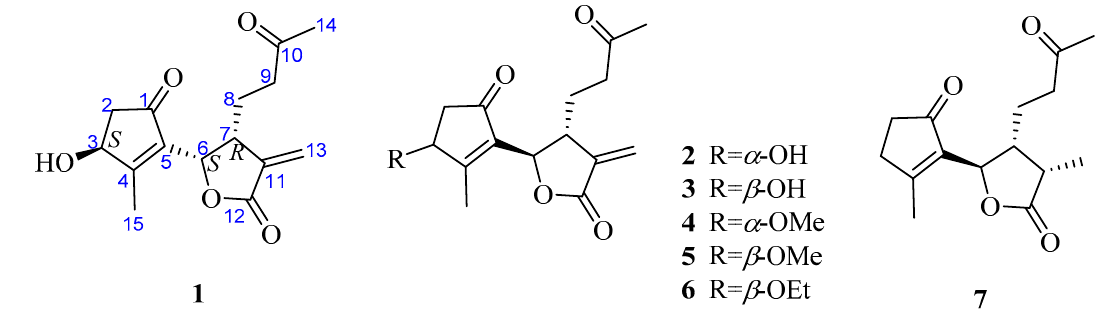
Figure 1. Chemical structures of compounds 1 – 7 .